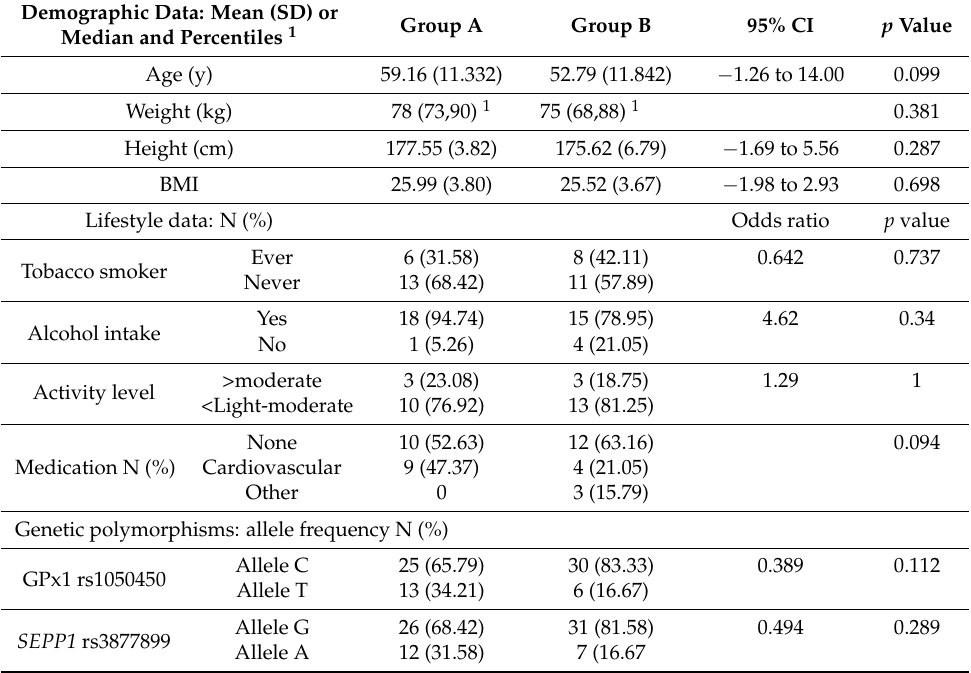
Table 1. Demographic, lifestyle, medication and genetic characteristics of subgroups A and B. Demographic Data: Mean (SD) or